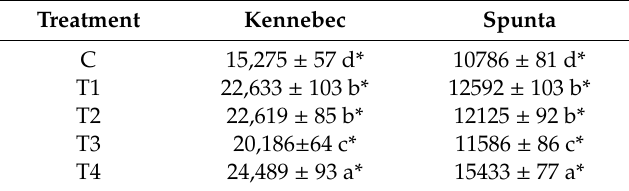
Table 1. Total yield (kg / ha) of the studied potato varieties in relation to the fertilization regime. Treatment